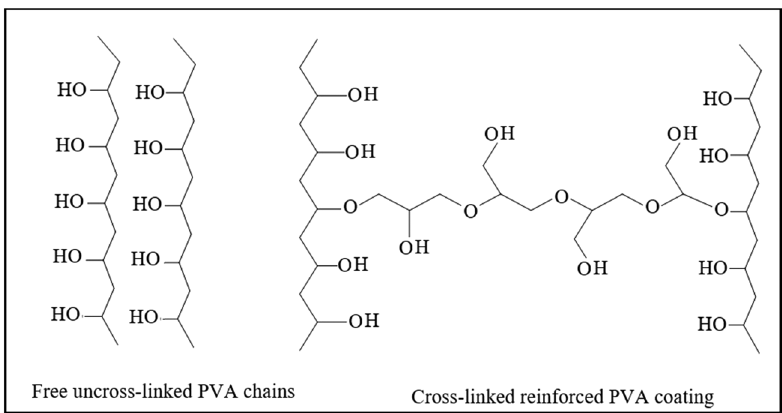
Figure 11: Scheme of chemical structure of free uncross - linked PVA chains and cross - linked reinforced PVA coating.